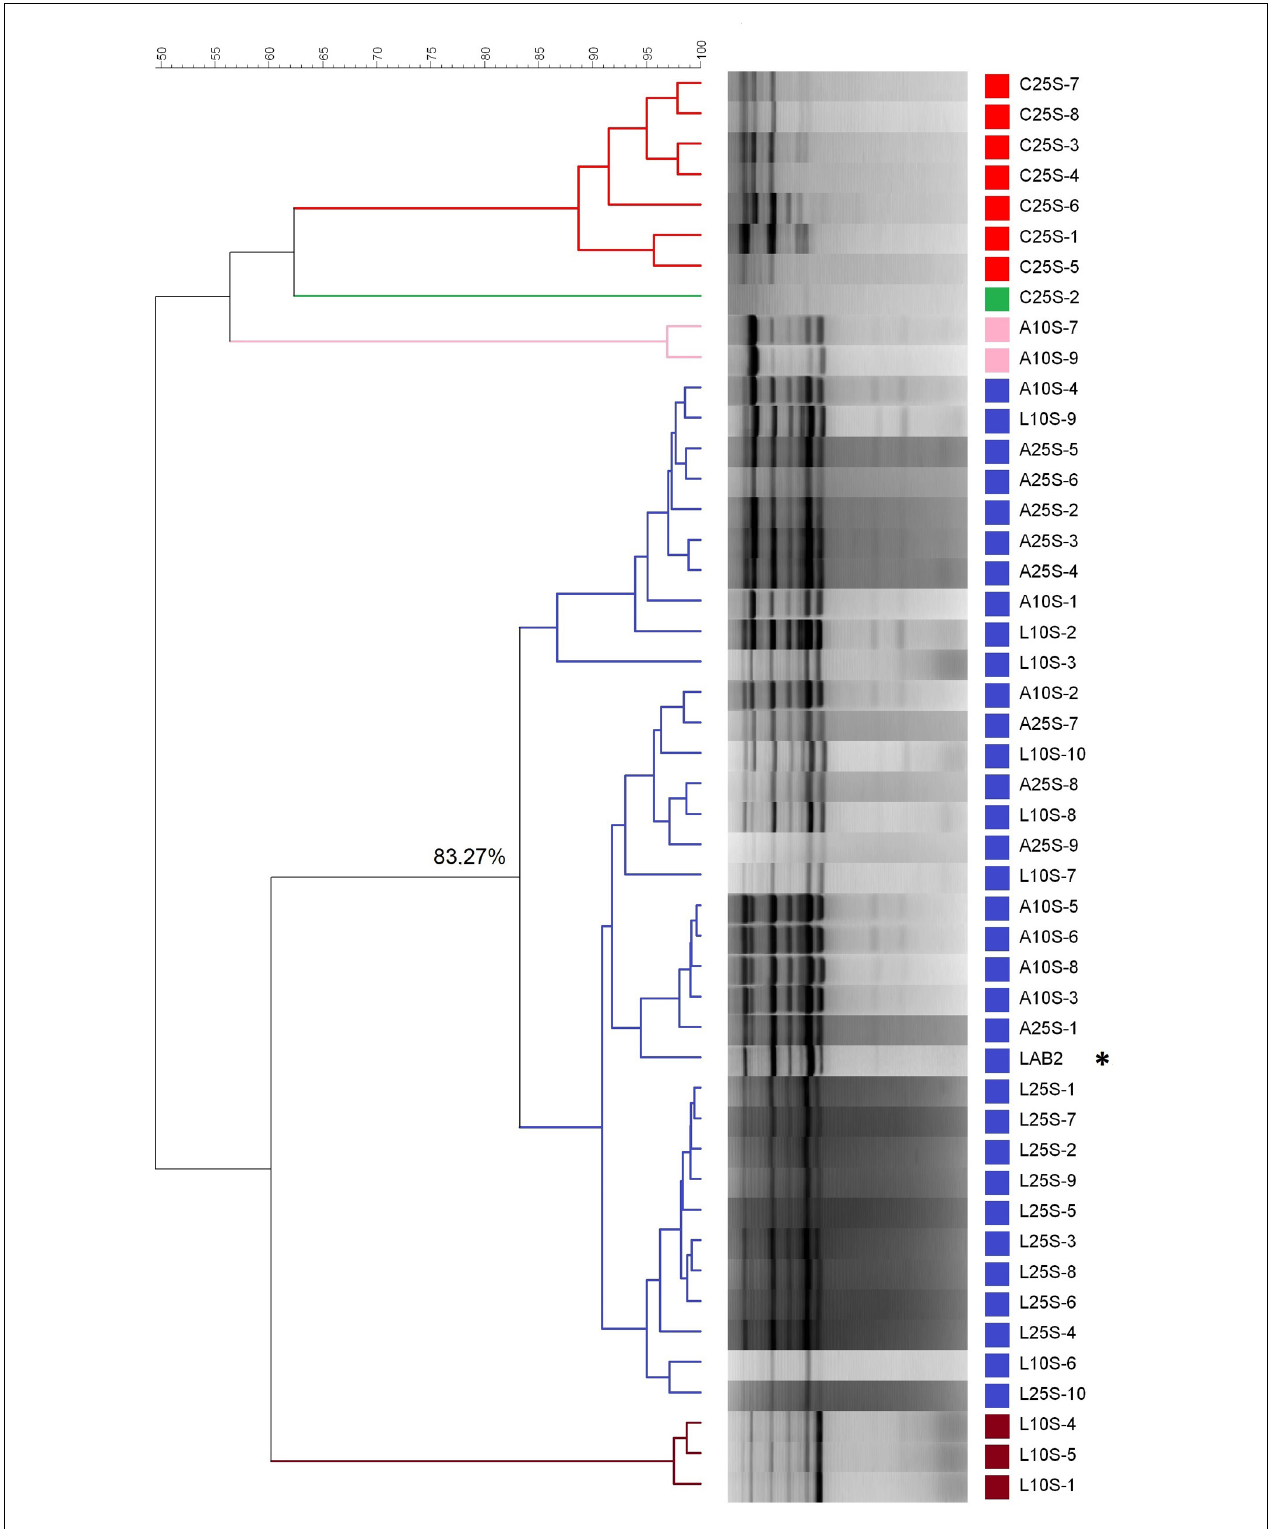
FIGURE 6 | Clustering analysis of the diverse LAB isolates obtained from the fermentation experiments carried out in September during 2012/2013 industrial fermentations. L and A stand for laboratory and industry pre-adapted inocula, respectively; 25 and 10 stand for the proportions of HCl/vessel added to the initial brine; C stands for the spontaneous fermentation. The last number refers to the order of isolation. ∗ Stands for the profile of inoculum LAB2.